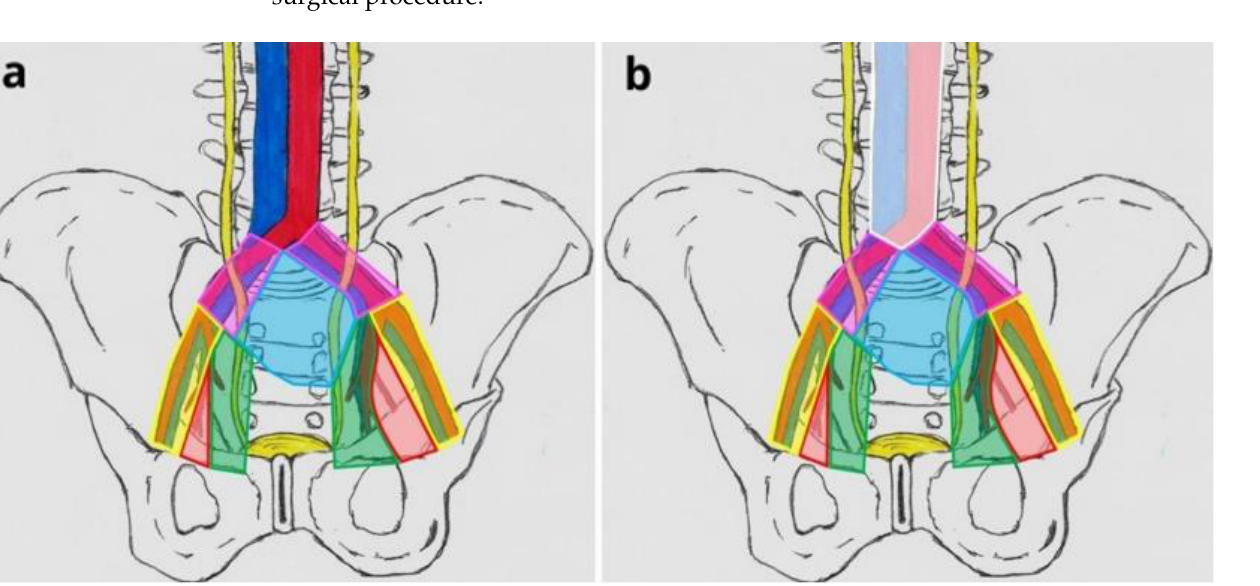
Figure 1. The anatomical diagram of PLND divided into templates: ( a ) — extended, and ( b ) — super- extended; the obturator fossa (red), external iliac vessels (yellow), internal iliac vessels (green), common iliac vessels (pink), the presacral area (blue), and the paraaortic/paracaval area (white). Lymph node metastases are detected in 16.7–29.3% of patients treated with